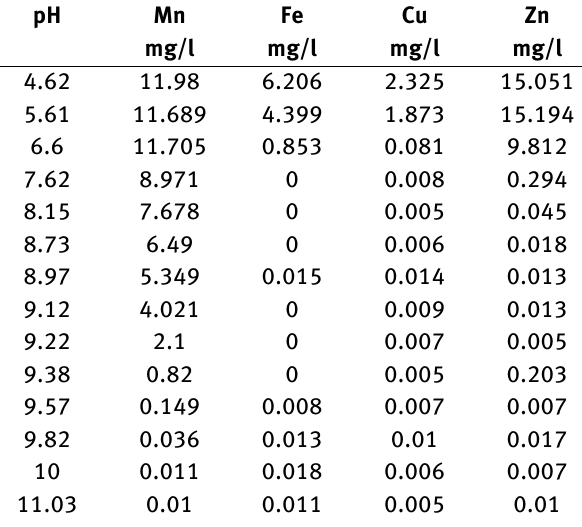
Table 1: Concentrations of metals (Mn, Fe, Cu and Zn) in mine water samples (in mg/l) measured by